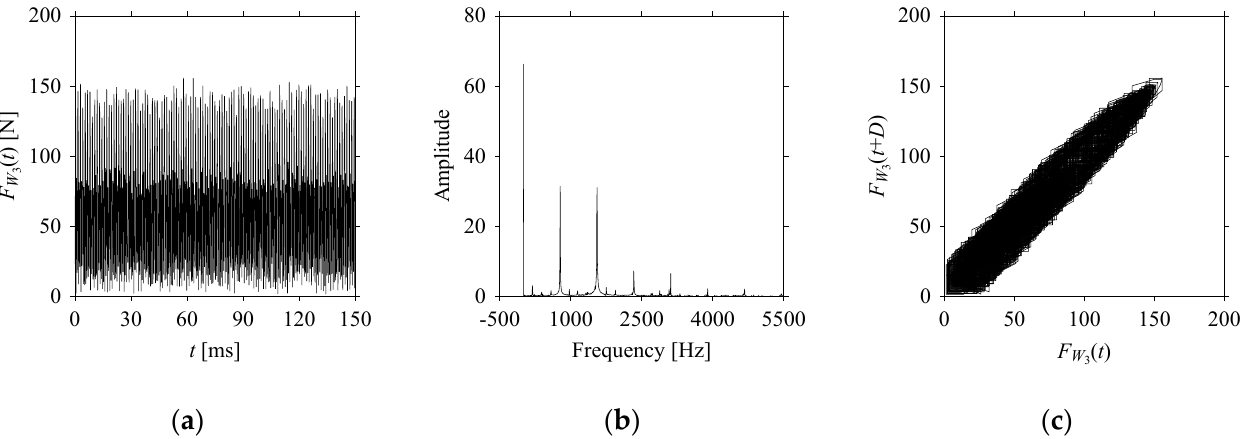
Figure A9. F W in the form of: ( a ) time series, ( b ) fast Fourier Transformation (FFT), and ( c ) delay map ( d = 1).